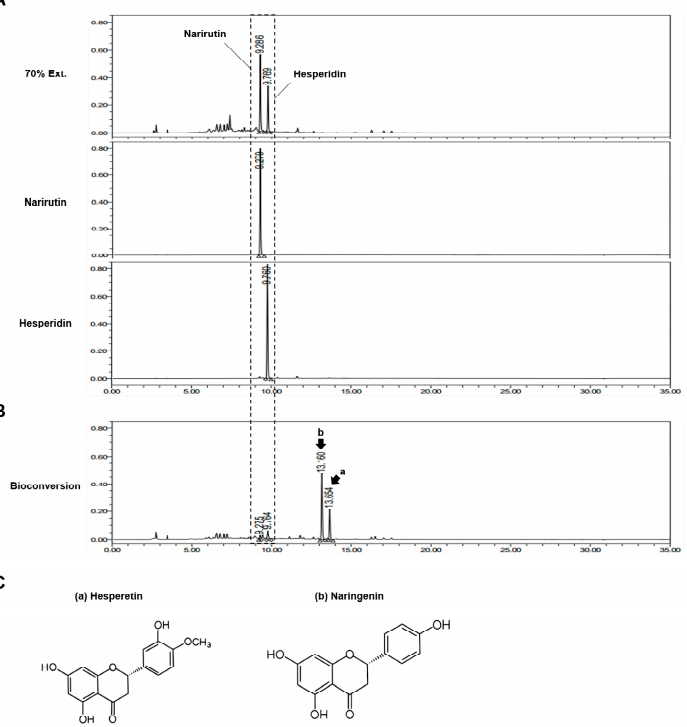
Figure 1. Compound analysis of Citrus unshiu peel (CUP). To identify the components of CUP, two kinds of metabolites extracted from the CUP using 70% ethanol ( A ) and bioconversion ( B ) were analyzed via high-performance liquid chromatography (HPLC). ( C ) Chemical structures of hesperetin and naringenin.